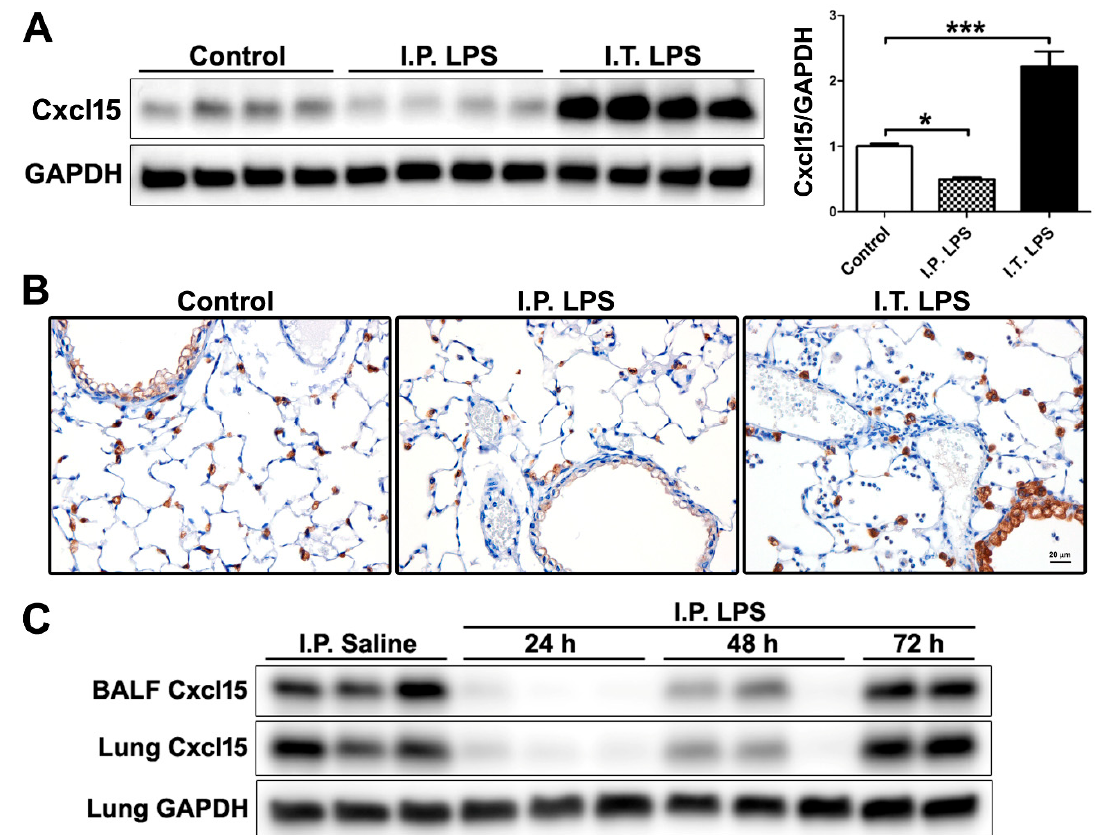
Figure 3. Expression of Cxcl15 in control, I.P. and I.T. LPS challenged mice. ( A ) Western blotting of lung tissue extracts. *, p < 0.05; ***, p < 0.001. Please note that protein samples from I.P. LPS group were placed next to the control group (I.T. saline) to better illustrate the down-regulation of Cxcl15 by I.P. LPS compared to the controls; ( B ) Immunostaining of Cxcl15 on lung tissue sections. Cxcl15